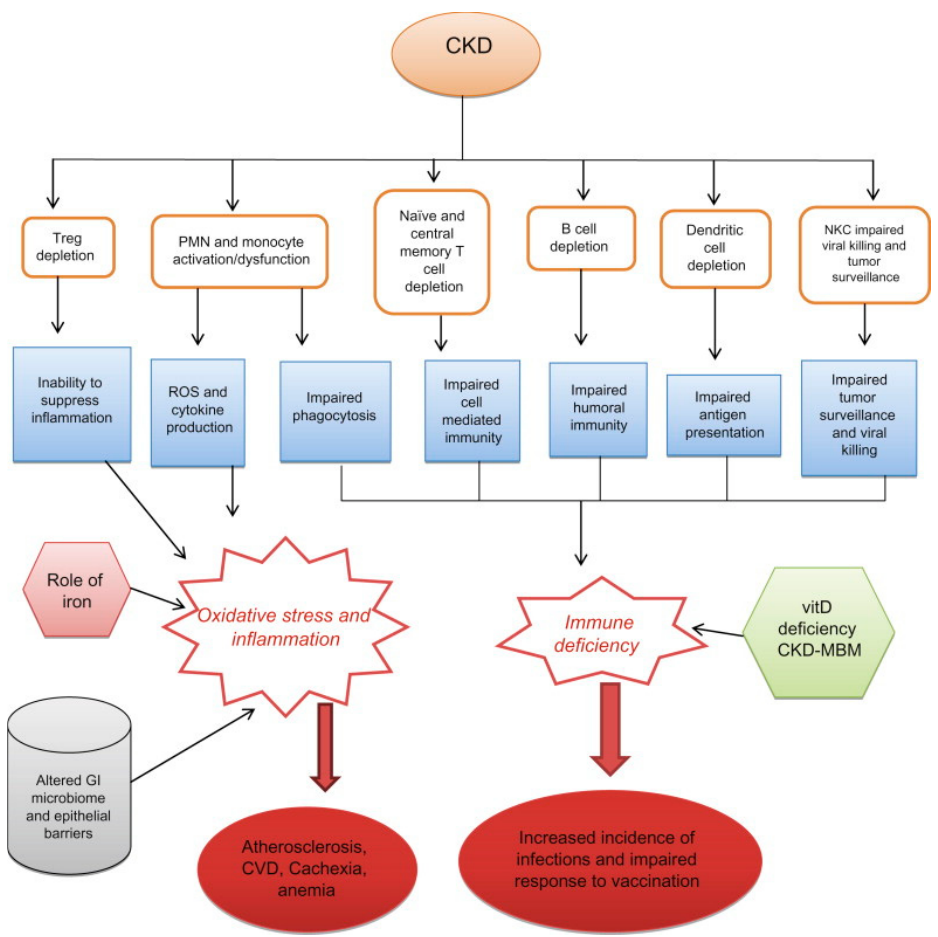
Figure 2 . Metabolic alterations in CKD that can impair the immune response. Loss of renal function causes retention of uraemic toxins and cytokines, leading to inflammation and increased oxidative stress. The resulting pro-inflammatory uraemic milieu causes activation and decreased function of virtually all immune cells. Uraemia might also cause epigenetic changes that could result in a shift in haematopoietic stem cell populations from lymphoid to myeloid, explaining why lymphoid cell numbers are reduced. These patients also have expanded populations of circulating pro-inflammatory cells of both the lymphoid (CD4 + CD28 − T cells) and myeloid cell lineages (CD14 + CD16 ++ monocytes). Response to anti-COVID-19 vaccine. In uraemic patients waiting for kidney transplanta- tion, multiple factors can lead to dysfunction of inflammatory and immune cells. These abnormalities can diminish the normal response to vaccination and may require a